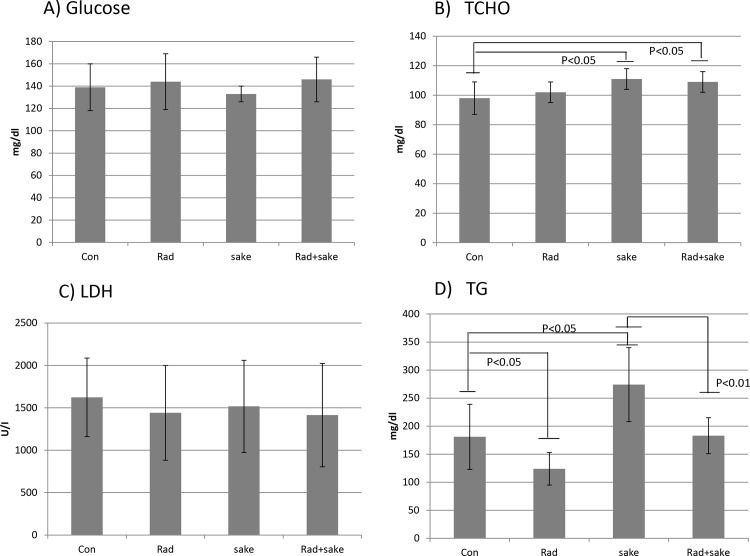
Effects of sake on metabolic biochemical markers in the serum of irradiated mice.(A) Glucose, (B) total cholesterol (TCHO), (C) lactose dehydrogenase (LDH), and (D) triglycerides (TG). Data are presented as means ± S.D. from seven mice in two independent experiments. Statistical analyses were performed by the unpaired t-test.